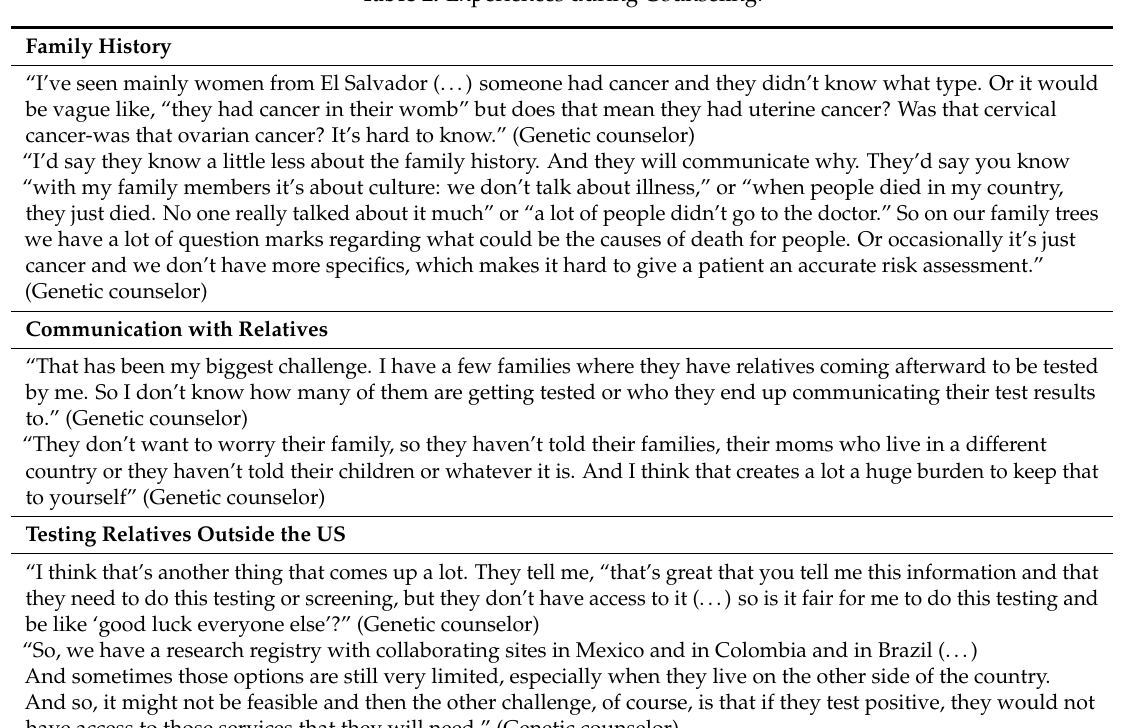
Table 2. Experiences during